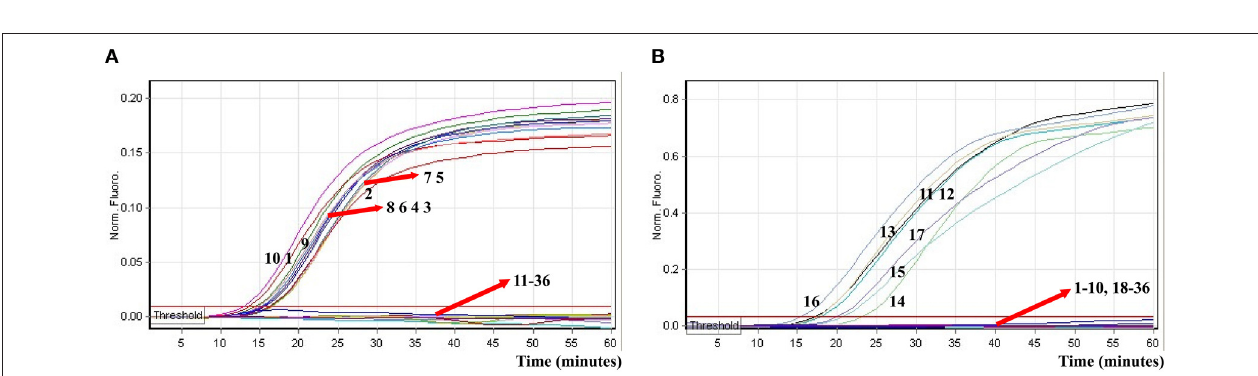
FIGURE 8 | The real-time analysis of multiplex targets in an ET-MCDA reaction. Two sets of ET-MCDA primers targeting invA and ipaH genes were simultaneously added to a reaction tube. (A,B) were simultaneously yielded from Cy5 (labeling Sal -E-CP2 of invA ) and Hex (labeling Shi -E-CP1 of ipaH ) channels, respectively. The analytical sensitivity of multiplex-ET-MCDA for simultaneously detecting Salmonella (A) and Shigella (B) was analyzed by real-time format, and signals 1, 2, 3, 4, 5, 6, 7, 8, 9, 10, 11, 12, and 13 represent DNA levels of 25 ng, 2.5 ng, 250 pg, 25 pg, 2.5 pg, 250 fg, 25 fg, 12.5 fg, 6.25 fg, 3.125 fg, 1.56 fg, and 0.78 fg per tube and negative control. The LoD of multiplex ET-MCDA assay for Salmonella detection was 6.25 fg per reaction, and the LoD of multiplex ET-MCDA for Shigella detection was 3.125 fg per reaction.